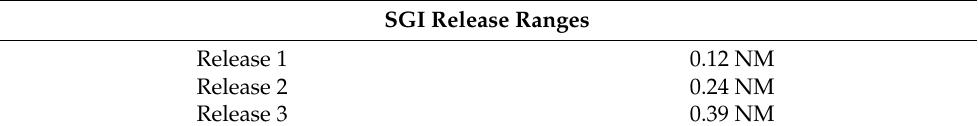
Figure 5. Set of modules used as targets in the measurement campaign. ( a ) Target T0; ( b ) Target T1; ( c ) Target T2; ( d ) Target T3. Table 3. Release ranges of the SGI modules.